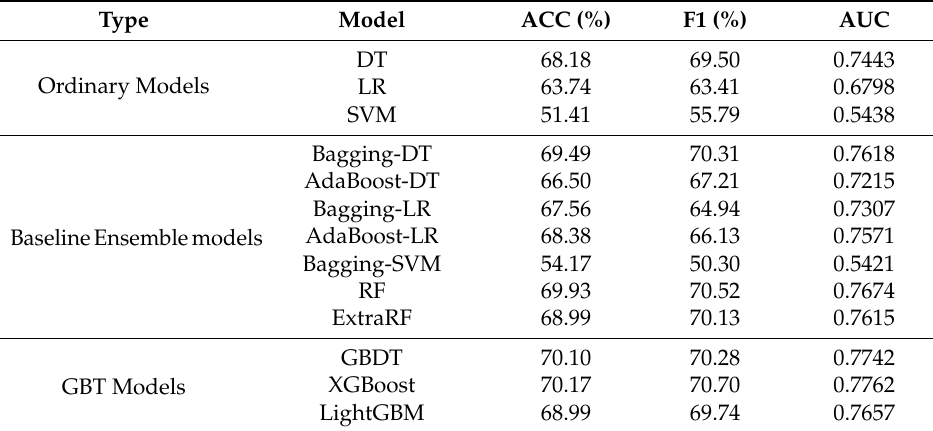
Table 5. Model comparison results on Facial cleanser